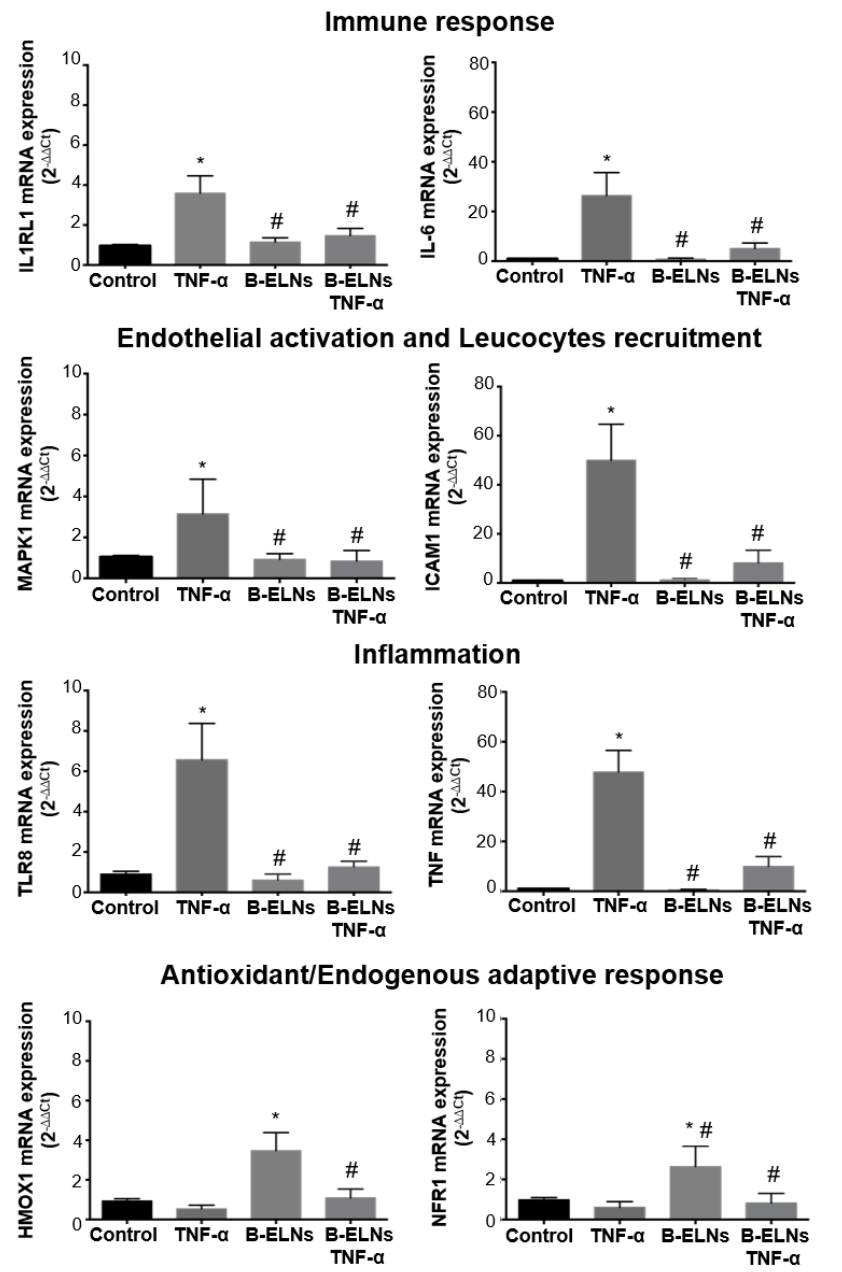
Figure 9. mRNA expression of selected DE genes by qRT-PCR. EA.hy926 cells pretreated for 3 h with B-ELNs (20 µ g / mL) and then exposed for 2 h to TNF- α (20 ng / mL). Cells exposed to vehicle (PBS) only were used as a control. Values of mRNA expression are expressed as 2 − ∆∆ Ct normalized to control (n = 4). * p < 0.05 vs. control; # p < 0.05 vs. control treated with TNF- α